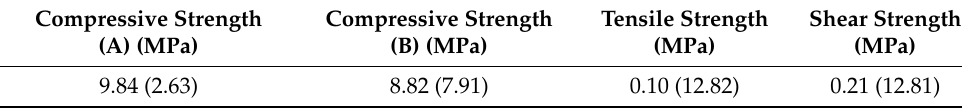
Table 3. Mechanical characterization of the masonry walls (CoV between